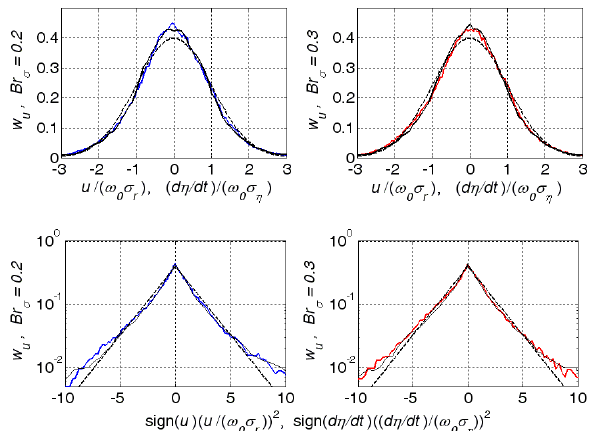
Fig. 12. Probability density function of the shoreline speed in linear (top) and semi-logarithmic (bottom) scale. Colour lines correspond to statistics of the moving shoreline and black lines show distribution of the vertical velocity in the incident wave. Black dashed lines show Normal distribution.